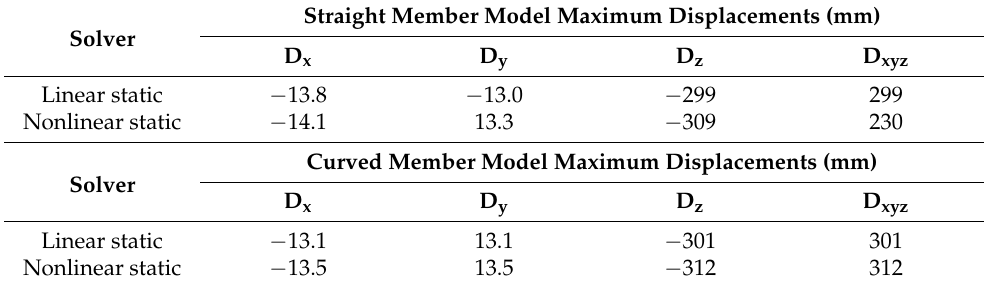
Table 5. Displacements under 1.2G +